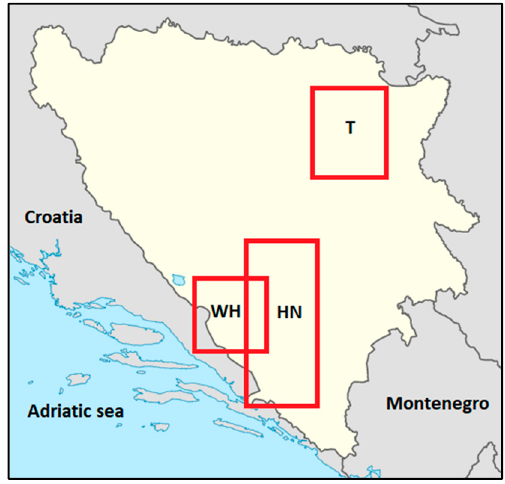
Figure 1. Bosnia and Herzegovina with the approximate location of the Counties where the sample was drawn from (HN-Herzegovina Neretva County, WH-Western Herzegovina County, T-Tuzla County).